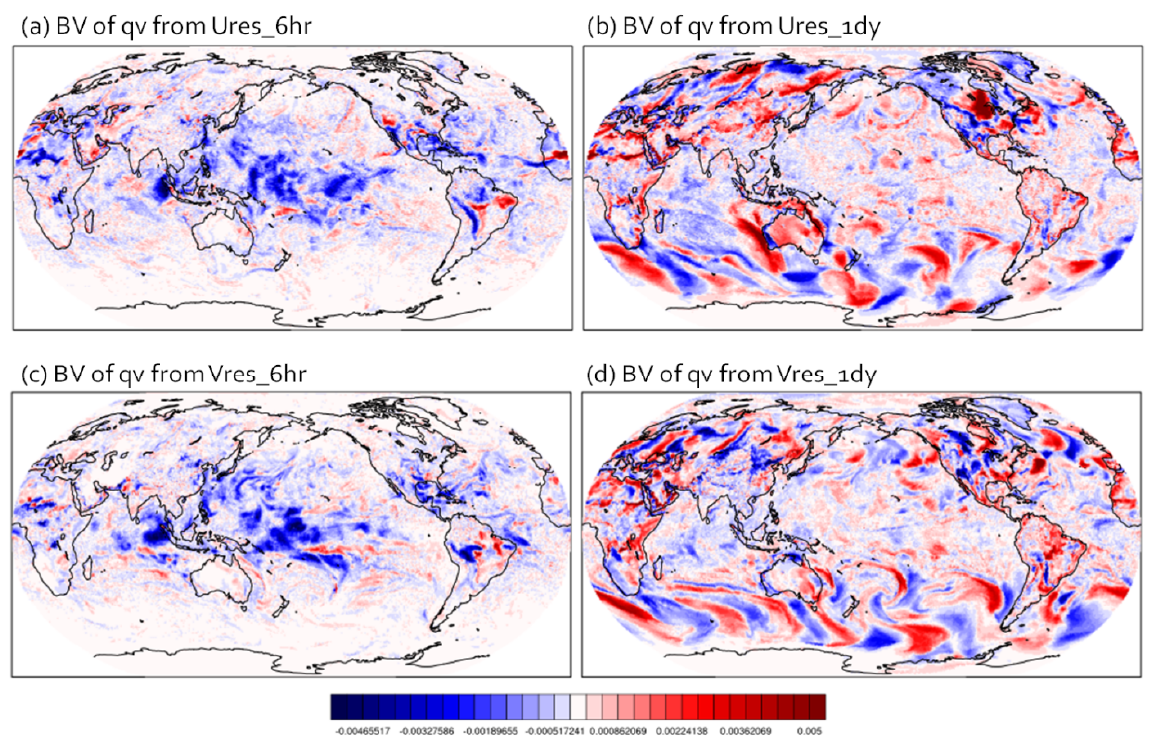
Figure 6. Time − averaged difference of specific humidity (kg/kg) near the 850 hPa model level, between mean BVs and the nature, from ( a ) Ures_6hr, ( b ) Ures_1dy, ( c ) Vres_6hr, and ( d ) Vres_1dy.